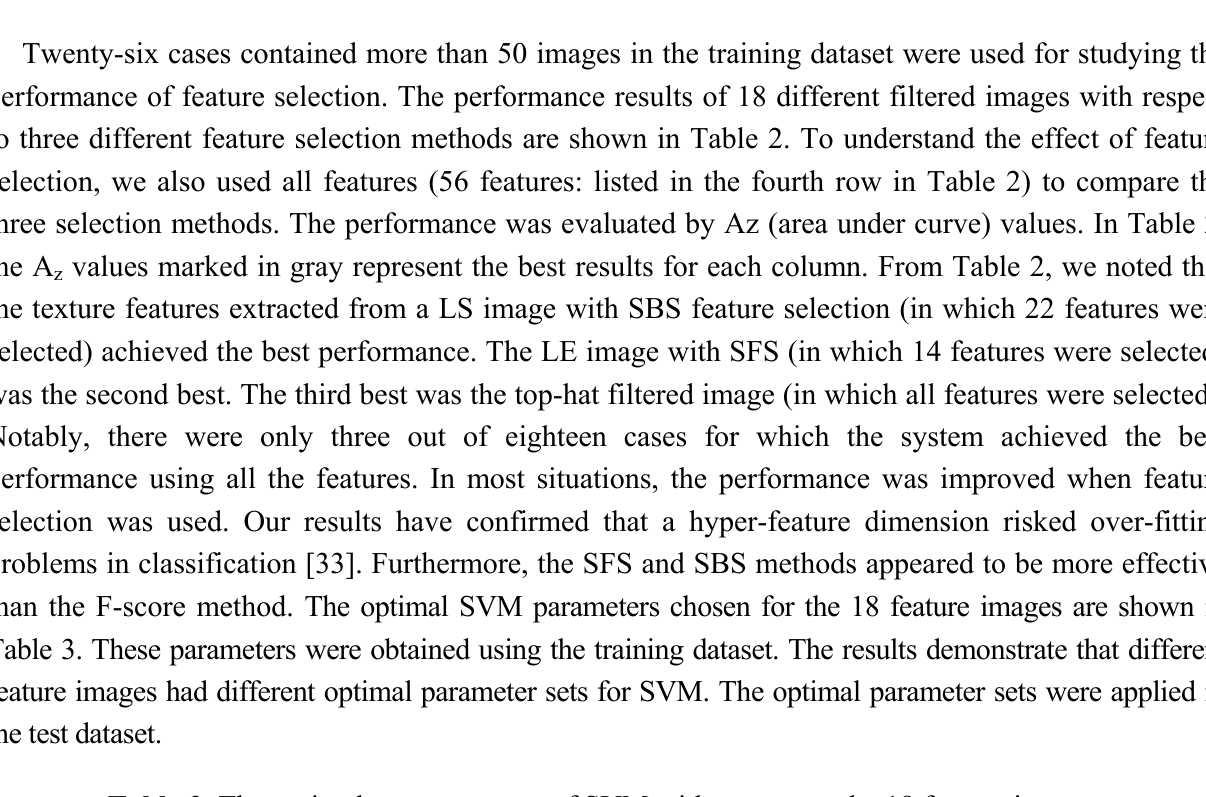
Table 3. The optimal parameter sets of SVM with respect to the 18 feature images. Parameters